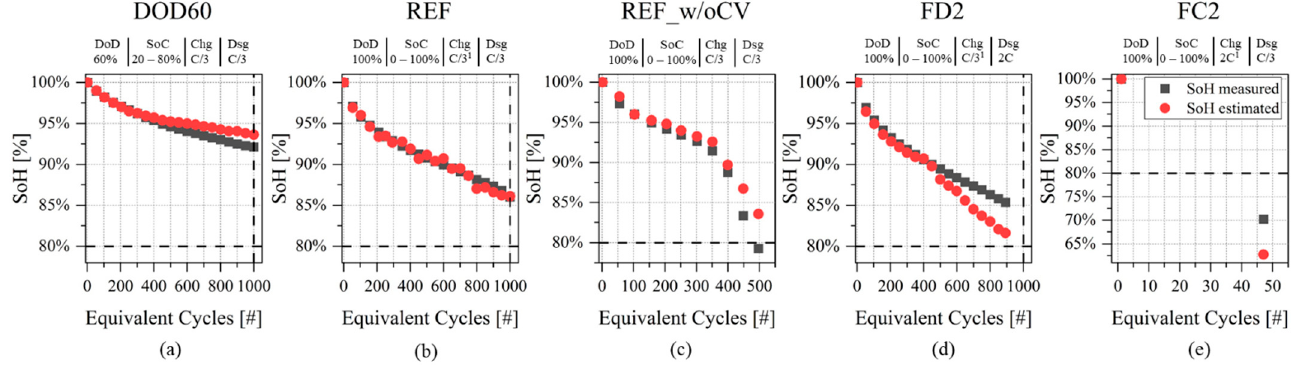
Figure 10. SoH model validation applying the model of Figure 9. ( a – e ) Results of application